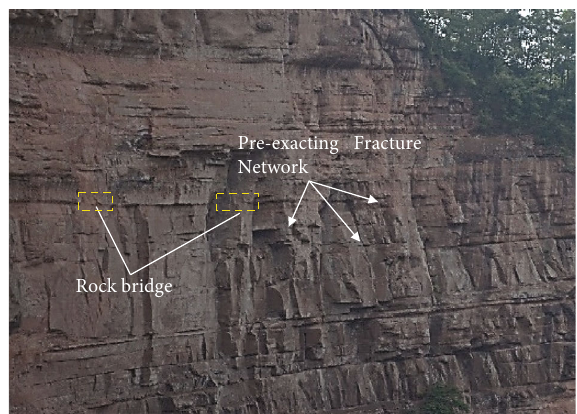
Figure 1: PFN-containing rock mass.